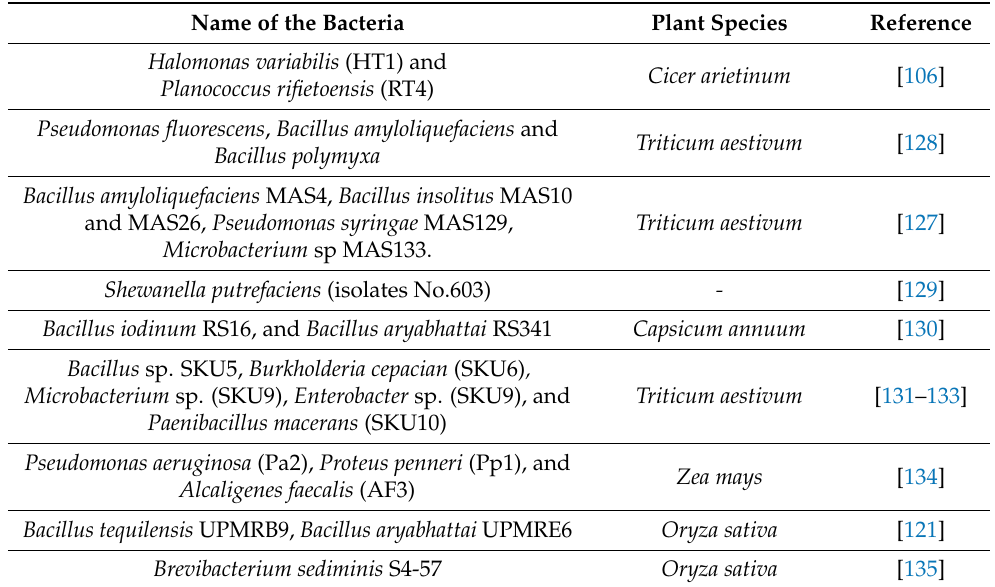
Table 3. The exopolysaccharide and biofilm producing salt-tolerant bacteria. Name of the Bacteria Plant Species Reference Halomonas variabilis (HT1) and Planococcus rifietoensis (RT4) Pseudomonas fluorescens , Bacillus amyloliquefaciens and Bacillus polymyxa Bacillus amyloliquefaciens MAS4, Bacillus insolitus MAS10 and MAS26, Pseudomonas syringae MAS129, Microbacterium sp MAS133.